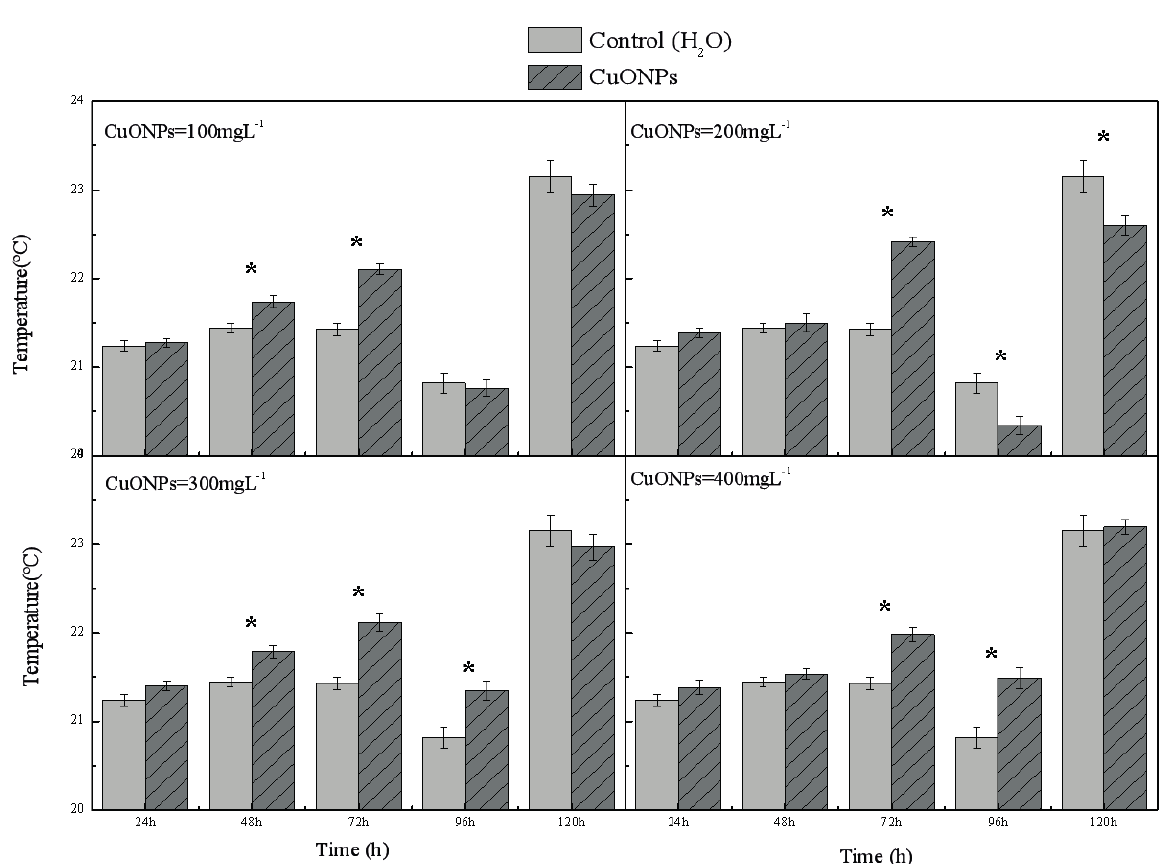
Figure 2. Mean temperature of 12 seeds of Sesbania virgata, as a function of time at all concentrations of CuONPs (< 50 nm) compared with the control (0 mgL -1 ). * Signifi cant difference (t-test, p < 0.05, n =